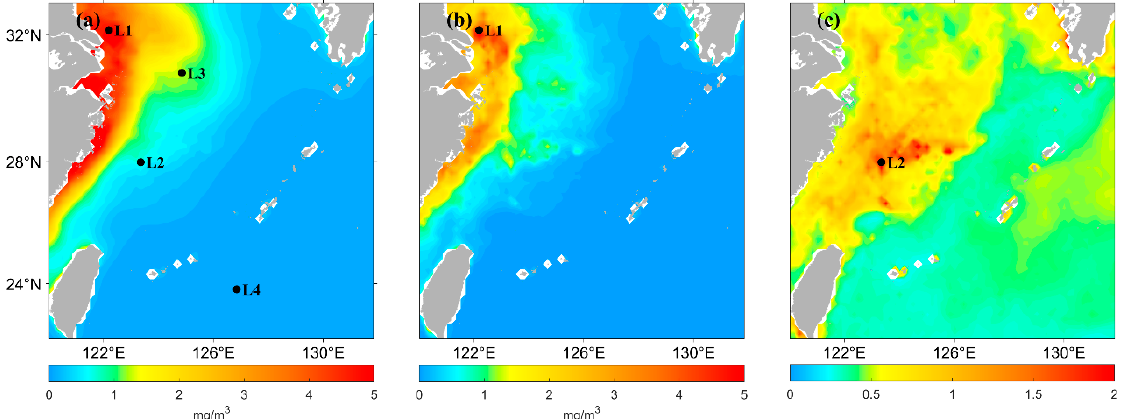
Figure 3. ( a ) Spatial distribution of annual mean Chl-a concentration from 2021 satellite observations in ECS. ( b ) Spatial distribution of the standard deviation of the Chl-a concentration from 2021 satel- lite-observed data in ECS. ( c ) Spatial distribution of the coefficient of variation in the Chl-a concen- tration from 2021 satellite-observed data in ECS. L1, L2, L3, L4 are the four different points